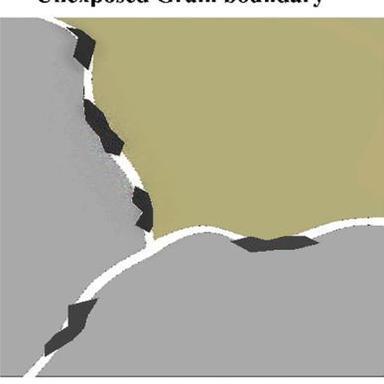
The schematic unexposed and exposed grain boundaries after long-term exposure. The M23C6 and γ́ created a continuous grain boundary.